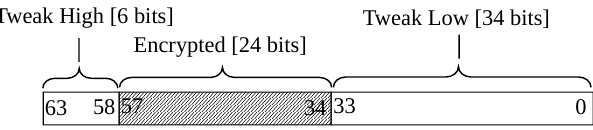
Figure 1: Pointer encryption format in Cryptographic Capability